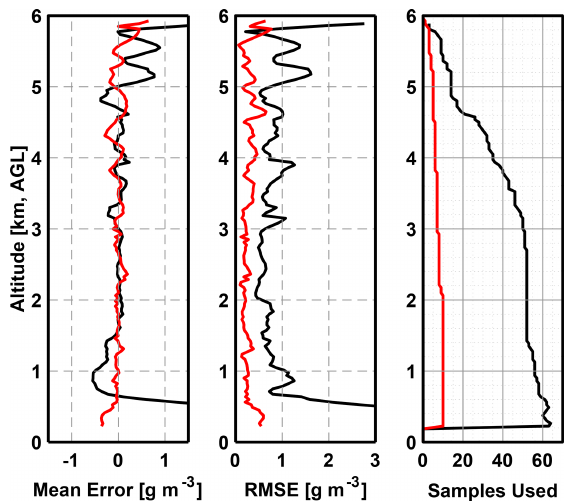
Figure 16. Plots of the absolute humidity mean error, RMSE, and number of samples used vs. altitude above ground level. The mean error and RMSE were calculated assuming radiosonde data were the truth. Results from a pair of field studies are shown. The plots in black are from the spring/summer field campaign (data from 19 April to 1 May 2019) at SGP with the Gen 4 system, without a near-range channel. The plots in red are from the wintertime test at the Marshall field site with the Gen 5 system (data taken